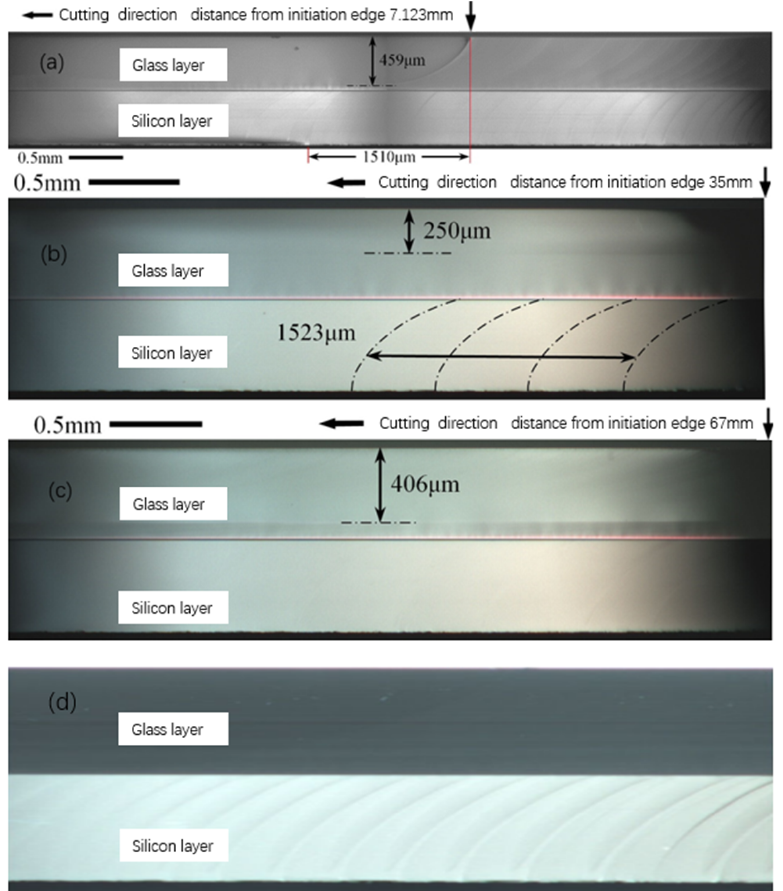
Figure 9. ( a ) High-speed optical photograph of the fracture surface about 7 mm from the entrance. ( b ) High-speed optical photograph of the fracture surface, about 35 mm from the entrance. ( c ) High- speed optical photograph of the fracture surface, about 67 mm from the entrance. ( d ) Low-speed optical photograph of the fracture surface [21].